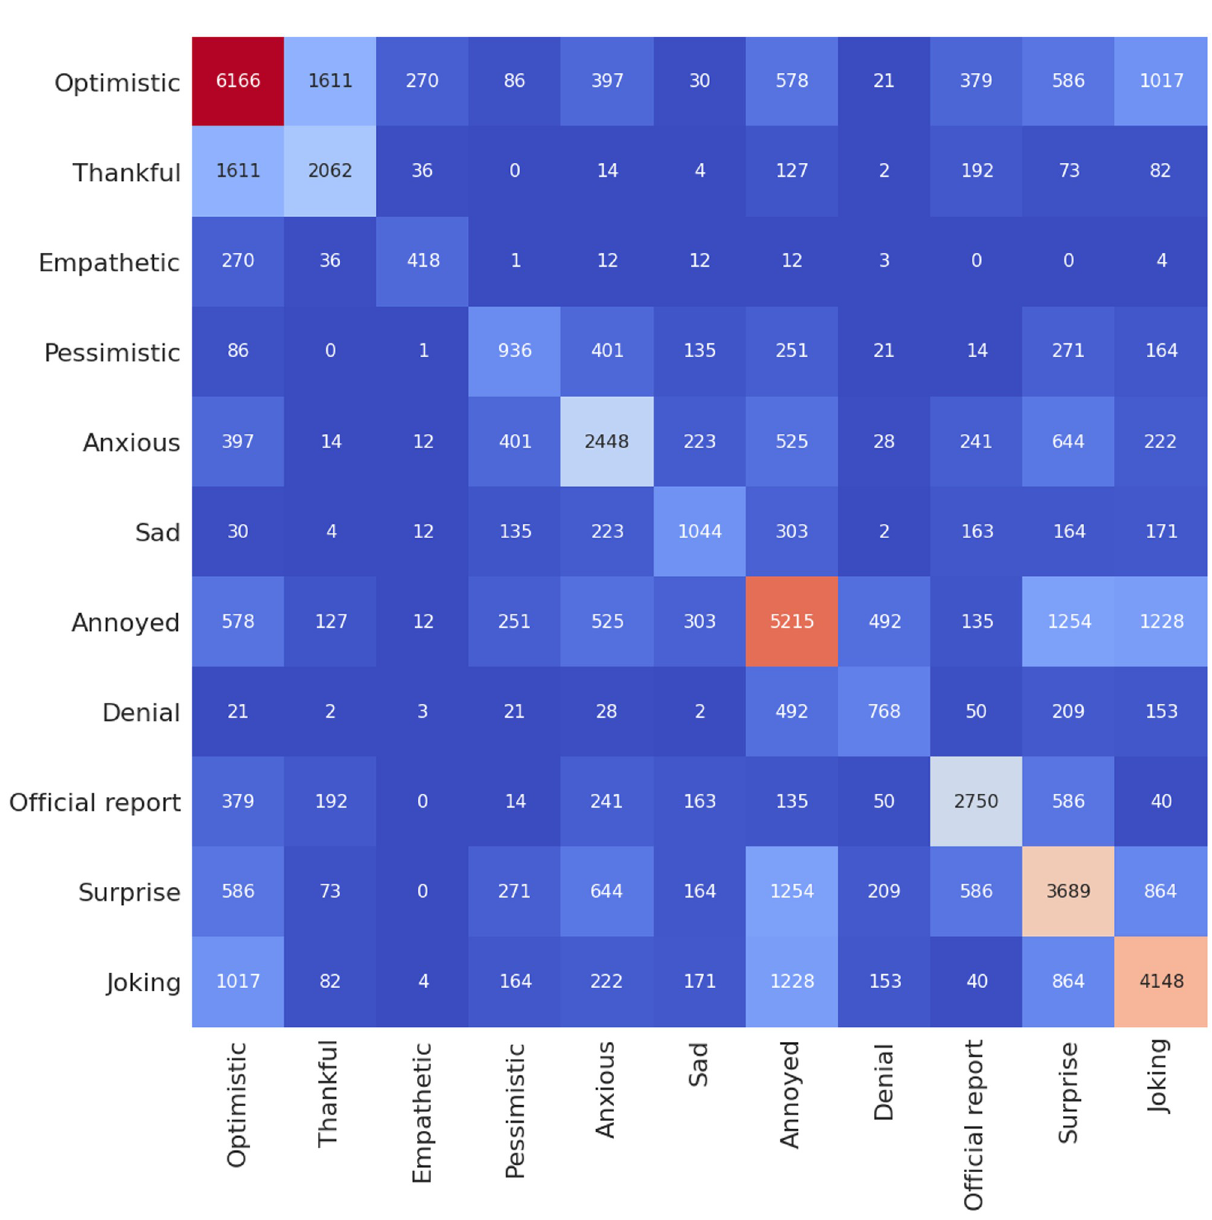
Fig 8. Heatmap showing number of occurrence of a given sentiment in relation to the rest of the sentiments for the Delhi dataset using the BERT model.